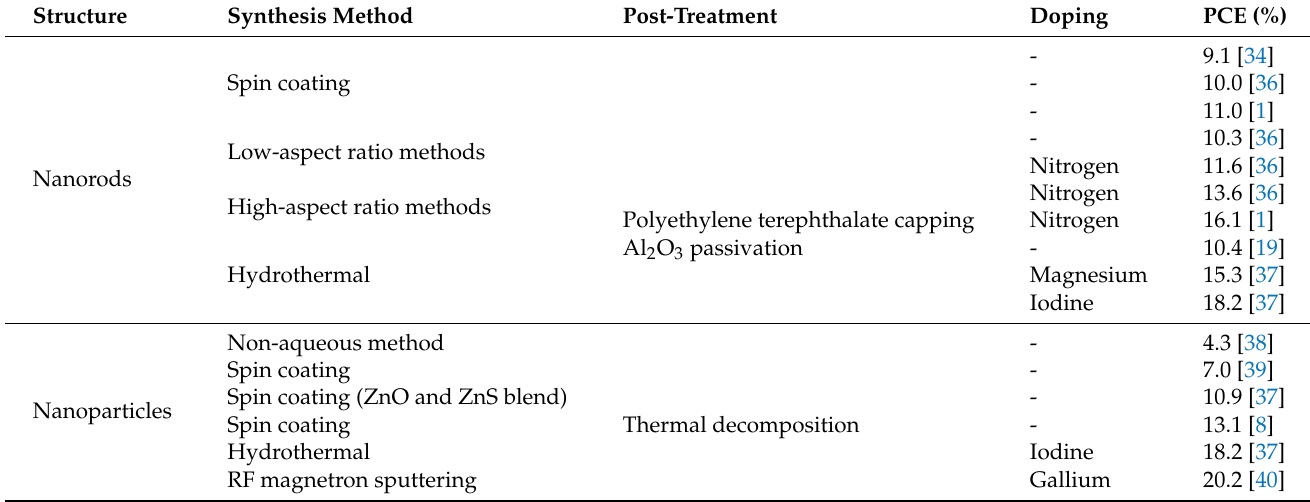
Table 1. A brief summary of recent results on the impact of ZnO structure, synthesis method, post-treatment, and doping on the PCE of the PSC